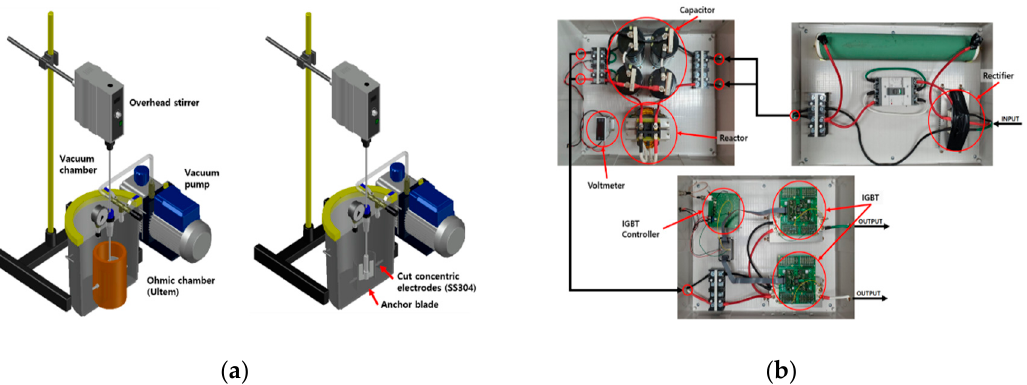
Figure 1. Ohmic–vacuum combination heating system: ( a ) schematic diagram of system, ( b ) ohmic heating power supply configuration.